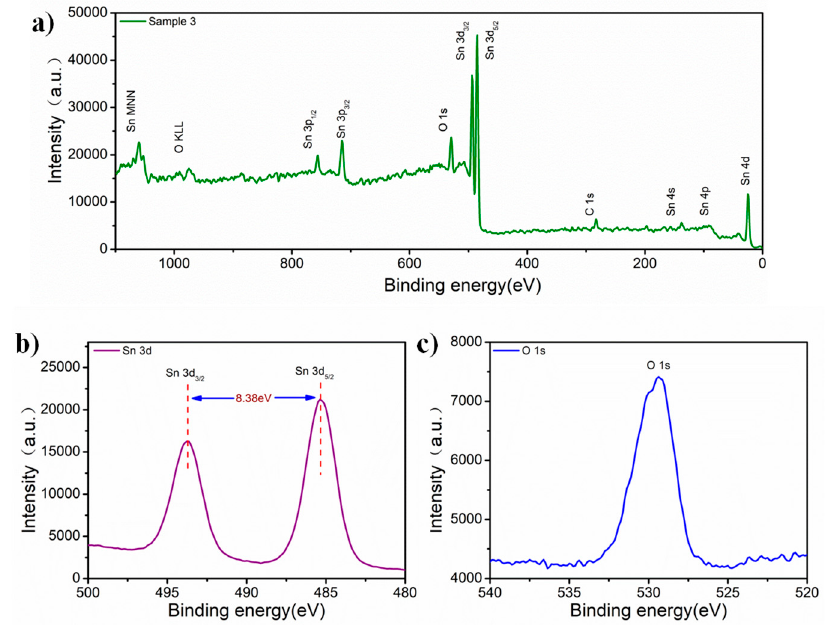
Figure 3. X-ray photoelectron spectroscopy of as-prepared Sample 3. ( a ) Sample 3 has Sn, O in the full spectrum; ( b ) High-resolution XPS of Sn 3d; ( c ) Sn–O bond in O 1s spectroscopy.